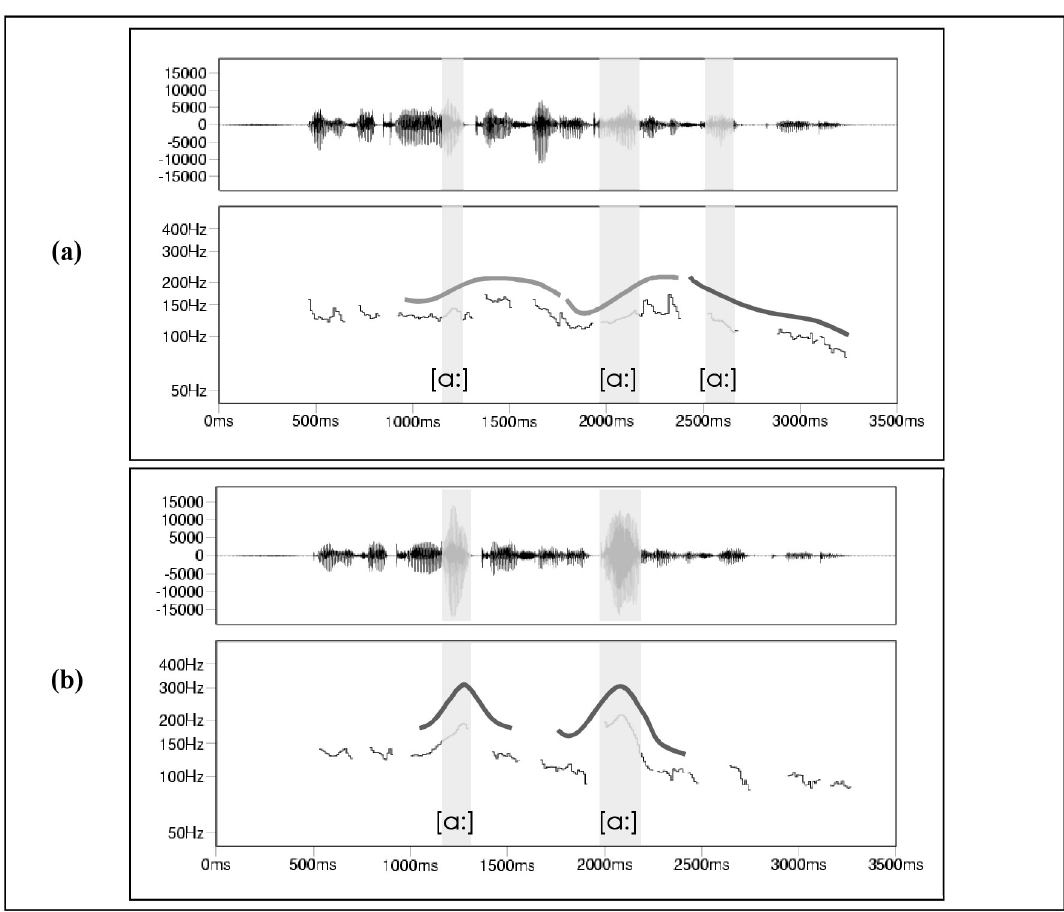
Fig 2. The partial sentence “ ... , wo sie von Kriminalkommissar Delgado befragt wurde” [ ... , where she was interrogated by Detective Delgado], realized in (a) a symmetrically structuring speech style and (b) an isolating/emphasizing speech style. Above the F 0 contour, there is a stylized visualization of its course. The shaded areas mark the vowels in the center of the syllables with sentence stress.